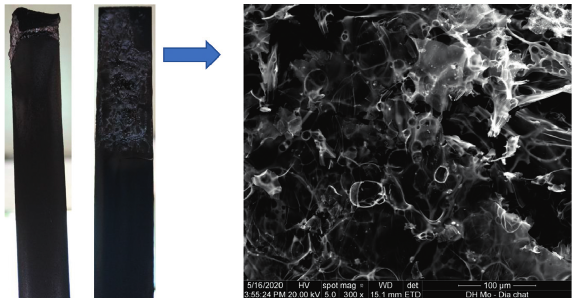
Figure 10: SEM morphologies of the residua of nanocomposites fly ash/MWCNTs/epoxy: 40 wt.% fly ash/0.04 wt.% from ignition by alcohol burner (UL